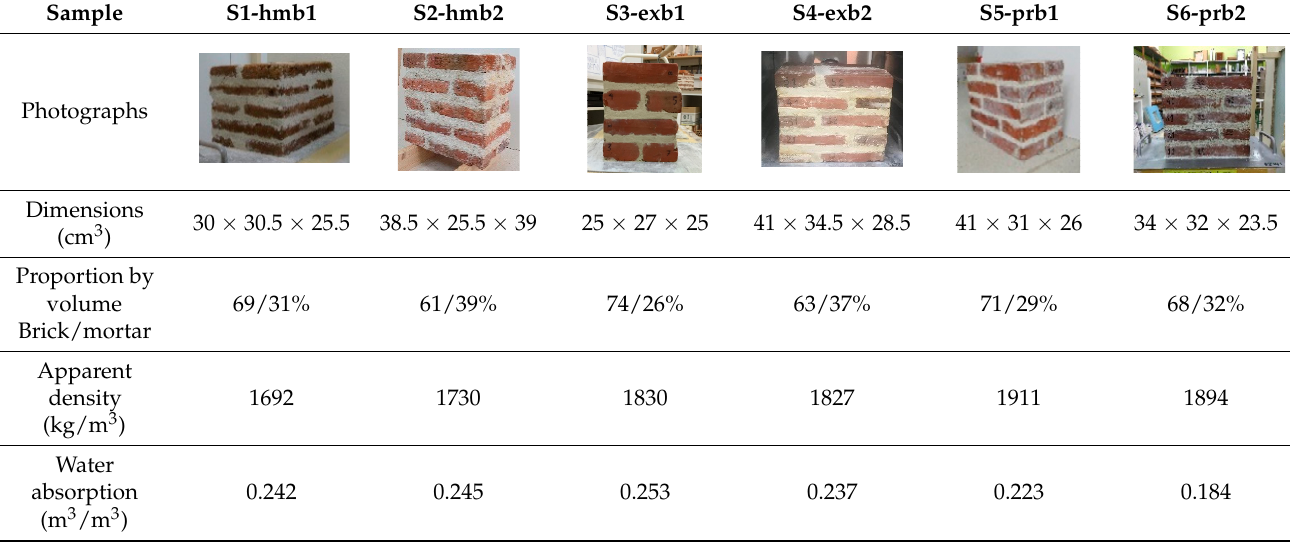
Figure 4. Pore size distribution in samples corresponding to the three types of brick studied.